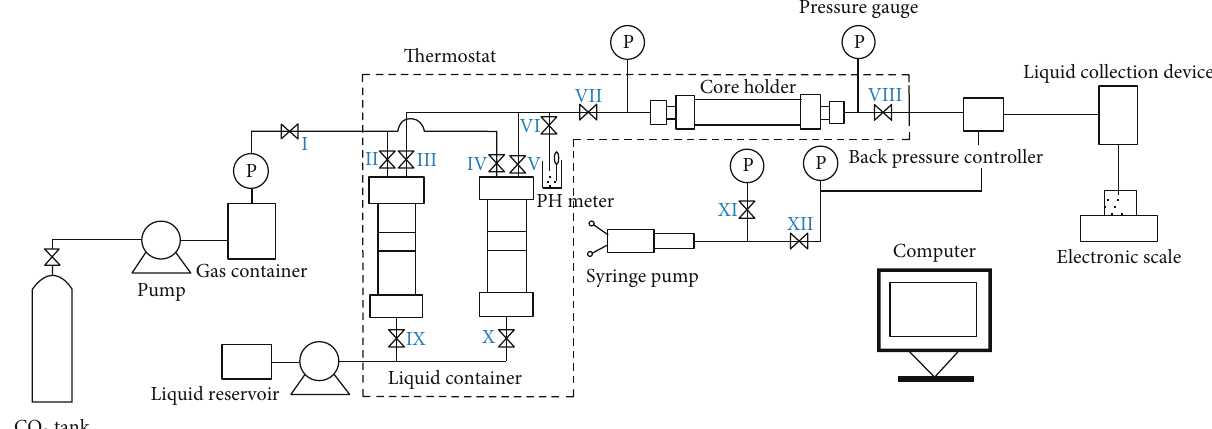
Figure 2: Schematic diagram of the experimental apparatus.